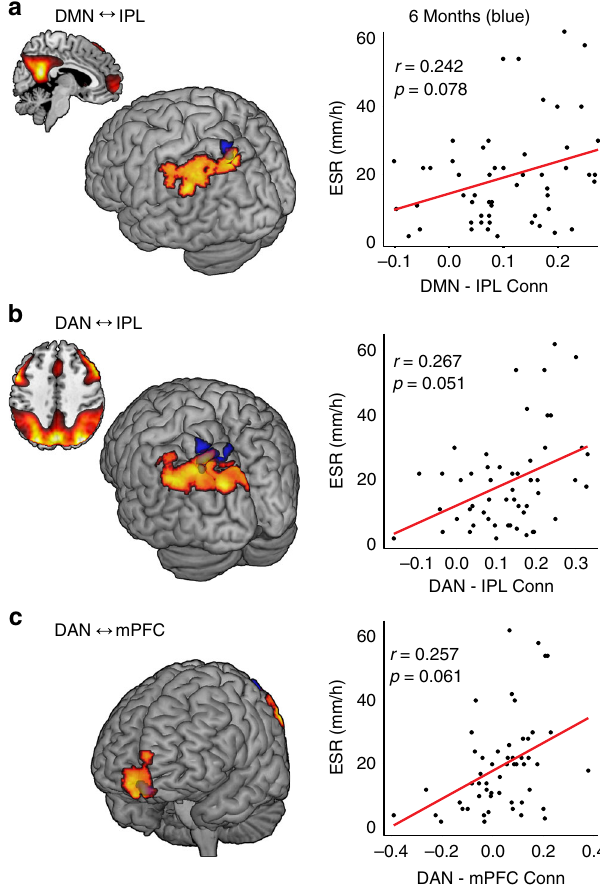
Fig. 4 Overlap of in fl ammation-associated functional connectivity at both time points. a Positive connections between the default mode network (DMN) with the inferior parietal lobule (IPL), b dorsal attention network (DAN) and IPL, c the DAN and medial prefrontal cortex (mPFC) at baseline and 6 months that were associated with increased peripheral in fl ammation measured by erythrocyte sedimentation rate (ESR). Scatterplots showing the association between ESR and the strength of connectivity are displayed next to each brain region. Extracted average Fisher r values from 8 mm spheres derived from the signi fi cant peak cluster coordinates identi fi ed at session 1 (baseline) were used at session 2 (month 6) and these were correlated with concurrent ESR values using Pearson correlations at p < 0.05 uncorrected. Baseline regions are shown in orange, 6 months in blue. Displayed at p = 0.005 voxel